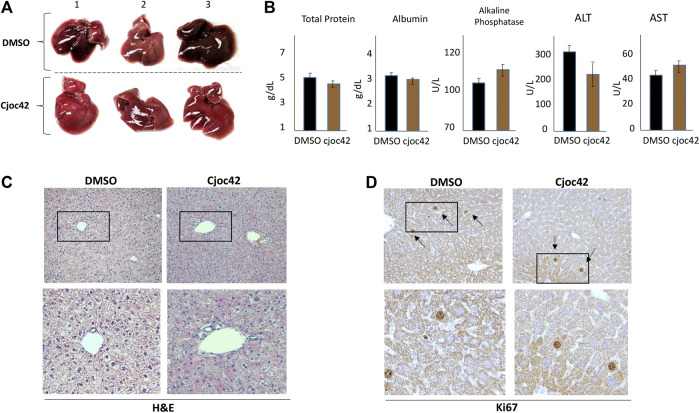
Toxicity study in mice shows that Cjoc42 is safe to administer. (A) Gross liver examination of three mice treated with DMSO and three mice treated with Cjoc42 1 mg/kg. No morphological differences were noted. (B) Serum hepatic parameters were analyzed with no differences seen between DMSO and Cjoc42 1 mg/kg treated mice. The serum was collected and analyzed on five mice in each group. (C, D) Histological examination of the livers of DMSO and Cjoc42 1 mg/kg treated mice at 10x magnification. Bottom images show images of regions of livers (boxed) under higher magnification. No differences were seen in H&E (C) and Ki67 (D) staining.